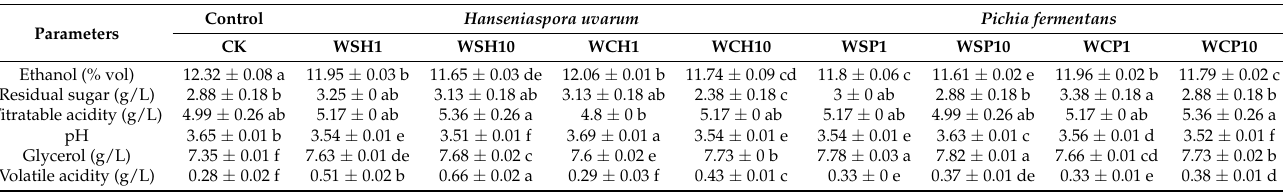
Table 4. Basic oenological parameters of wine